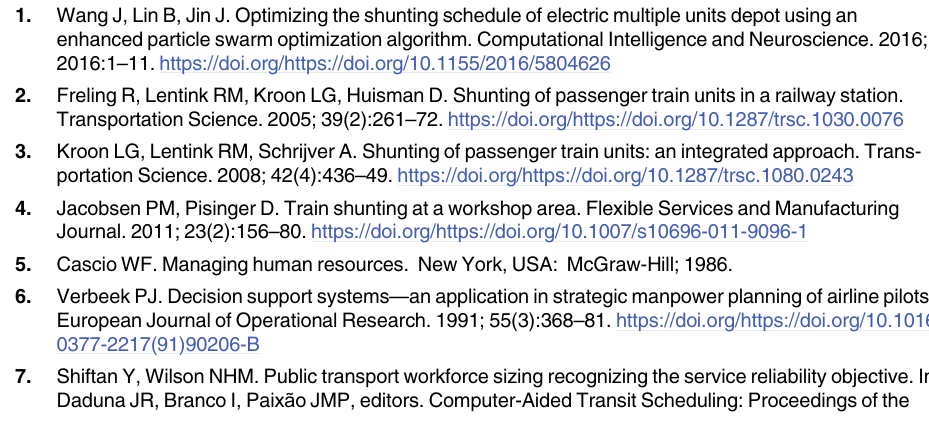
S1 Table. Walking distance between each two points (unit: m).